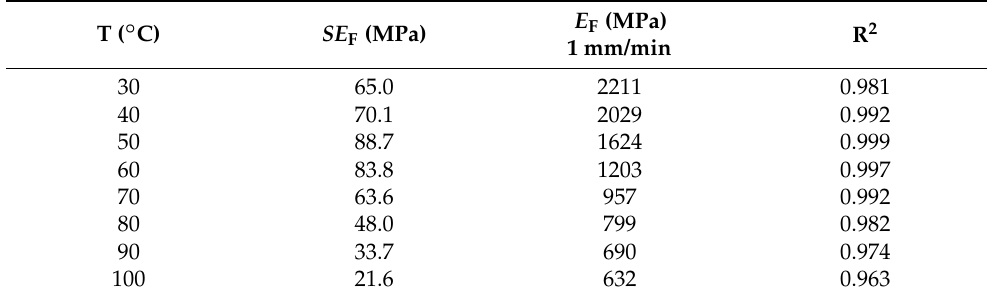
Table 1. Slope and independent terms of the logarithmic adjustment between flexural modulus and strain rate for PA66.